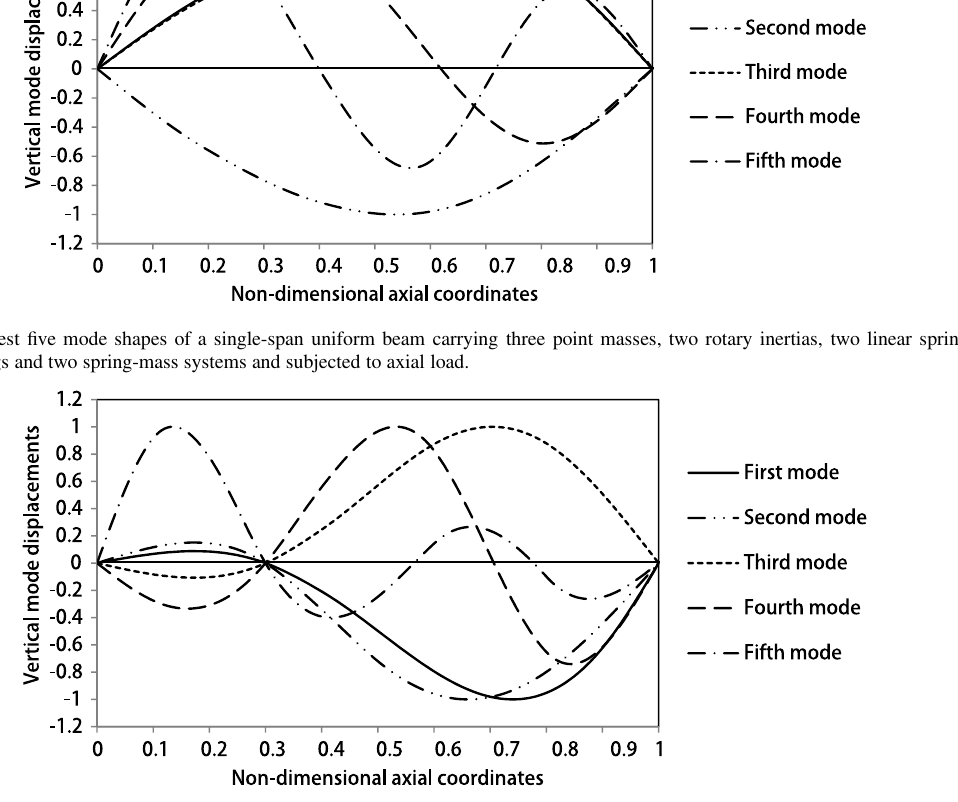
Fig. 8. The lowest five mode shapes of a two-span uniform beam carrying three point masses, two rotary inertias, two linear springs, two rotational springs and two spring-mass systems and subjected to axial load.